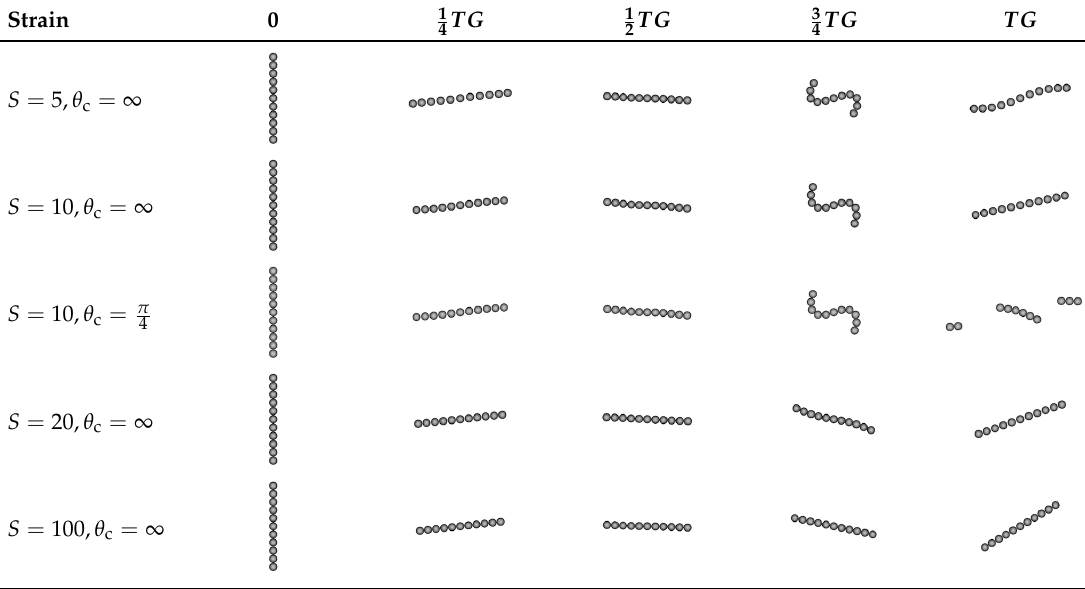
Table 1. Bending modes of a fiber with length L f = 11 ∆ x for varied dimensionless stiffness. One example with S = 10 and critical fiber bending angle θ c = π